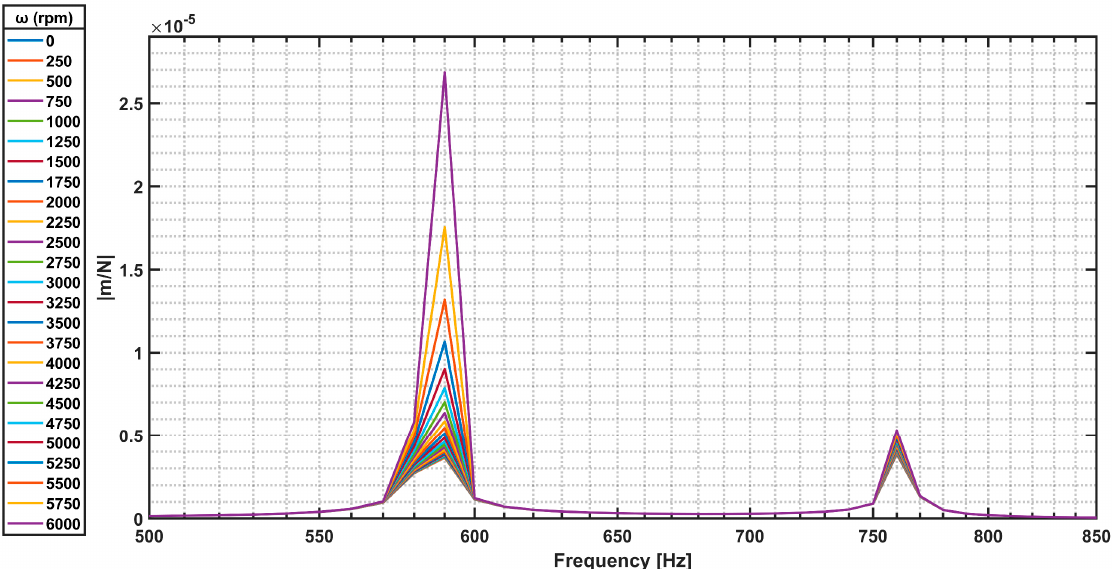
Figure 13. Transfer function plotted at different ω (zoom to the region of interest).